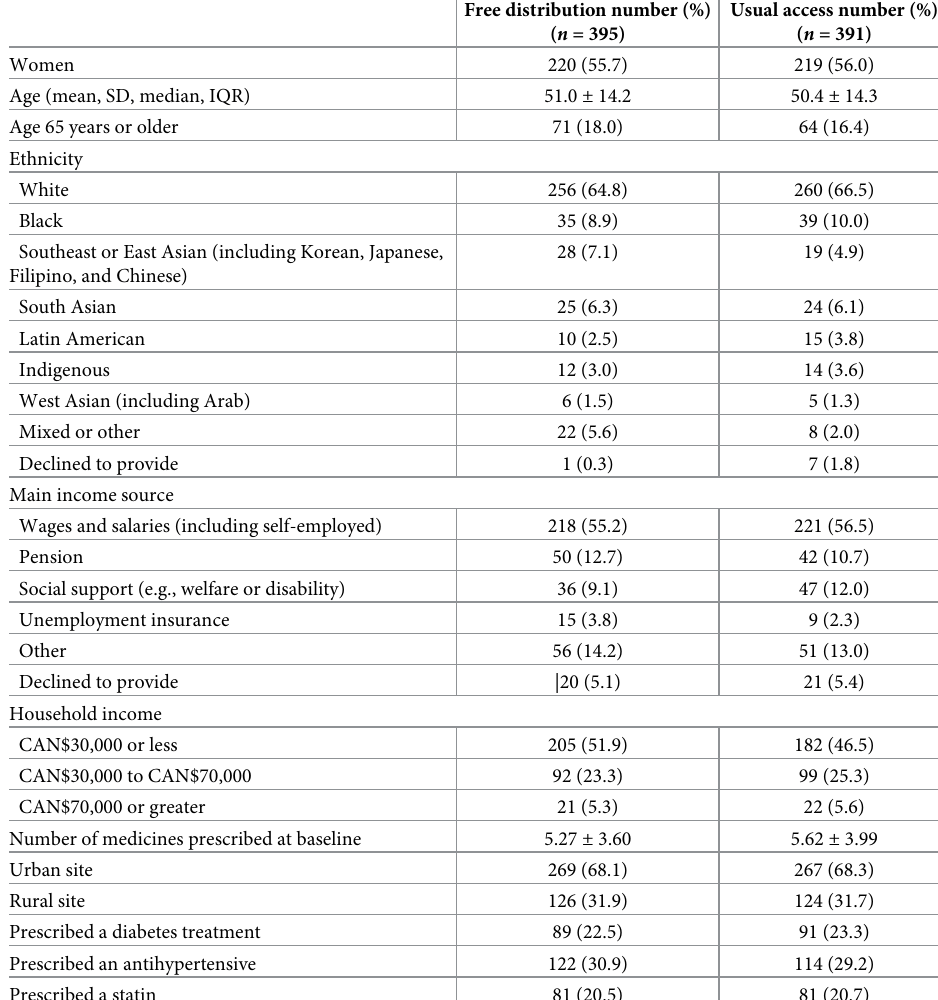
Table 1. Baseline participant characteristics by